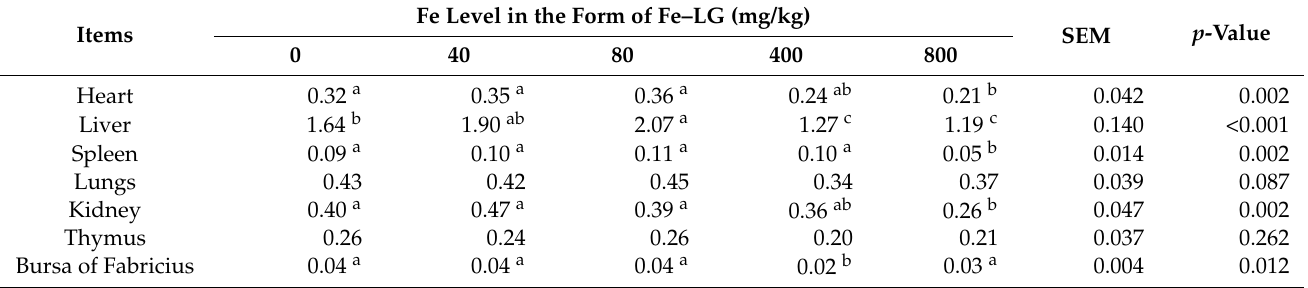
Table 7. Effects of dietary supplementation with high doses of Fe–LG on organ indices of broilers on day 42 (%) 1 .